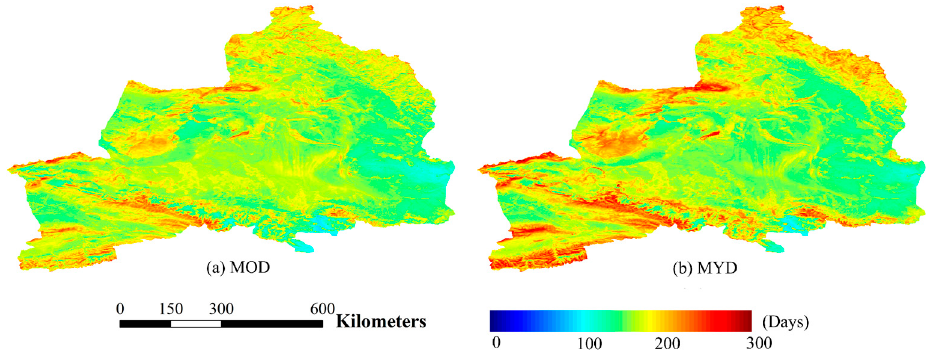
Figure 5. Cloud cover duration maps of the standard ( a ) MOD: MOD10A1 and ( b ) MYD: MYD10A1.